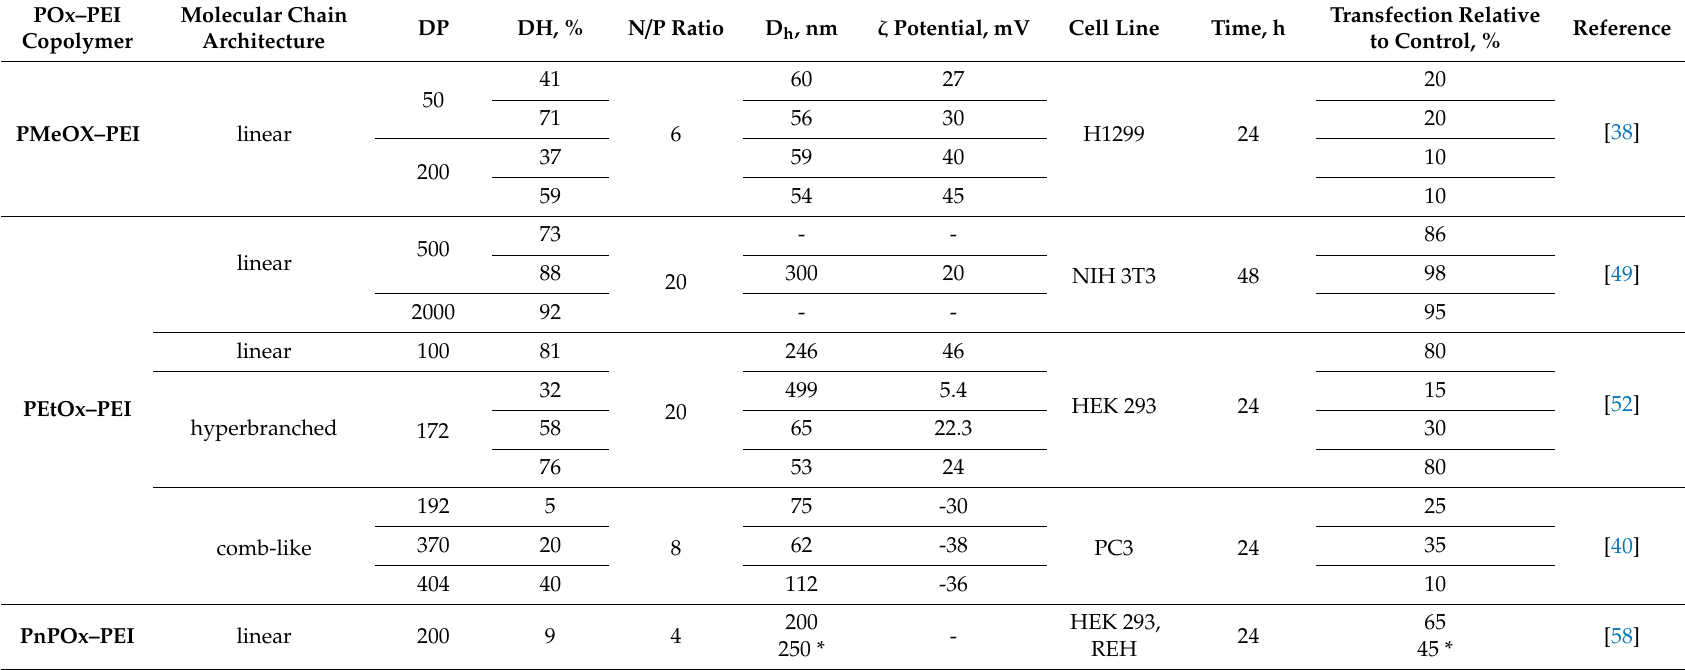
Table 5. Macromolecular characteristics, physicochemical properties, and transfection e ffi ciency of polyplexes based on POx–PEI